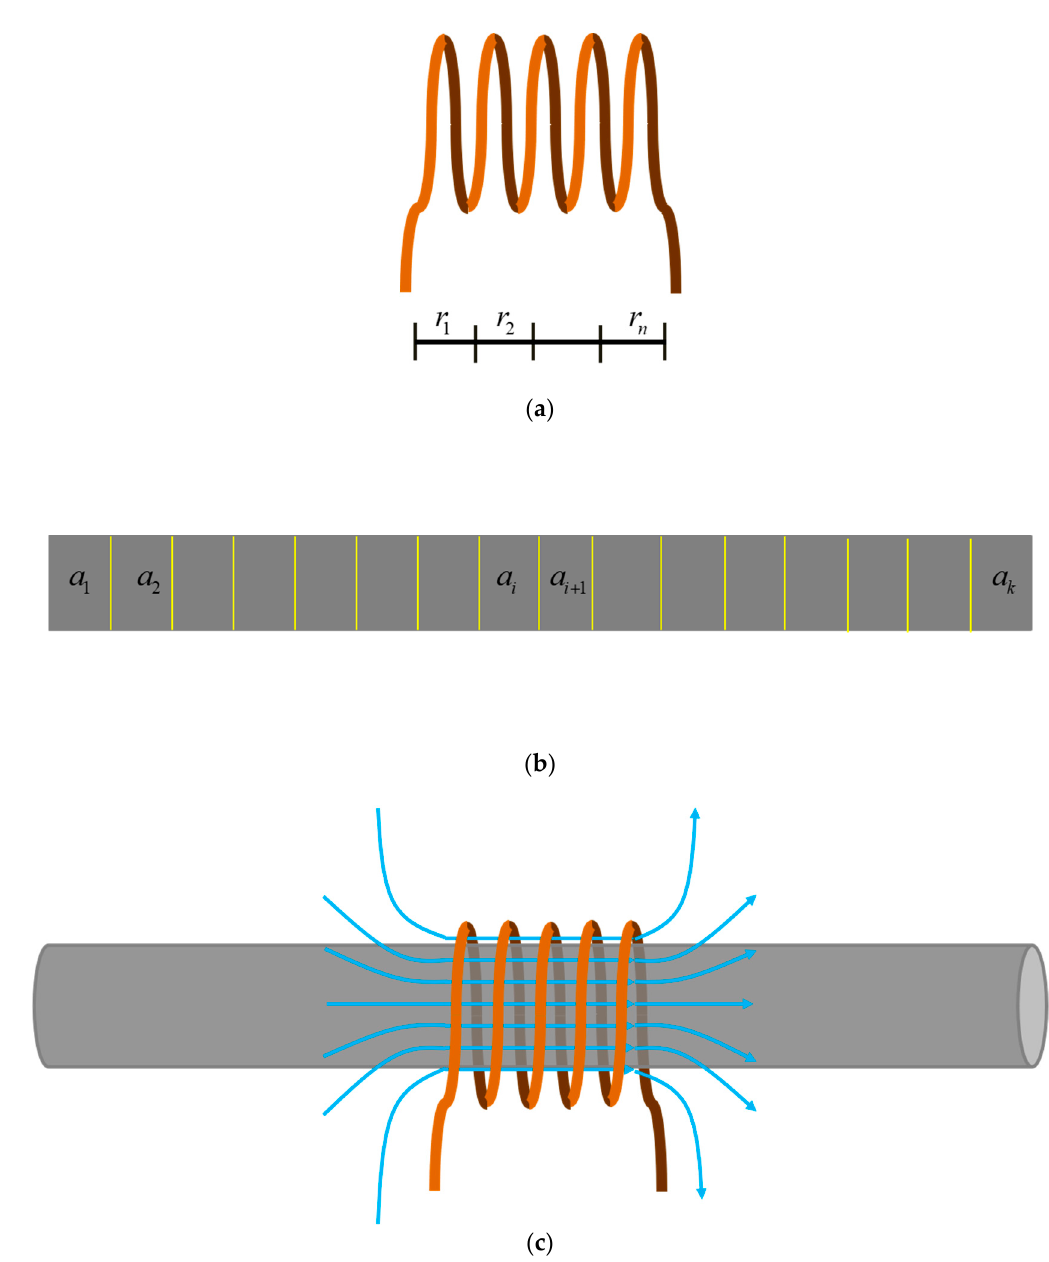
Figure 1. ( a ) The coil and the digitized response function r . ( b ) A long rock sample and digitized fluid content function a . ( c ) Illustration of the relative position between the coil and the rock sample.